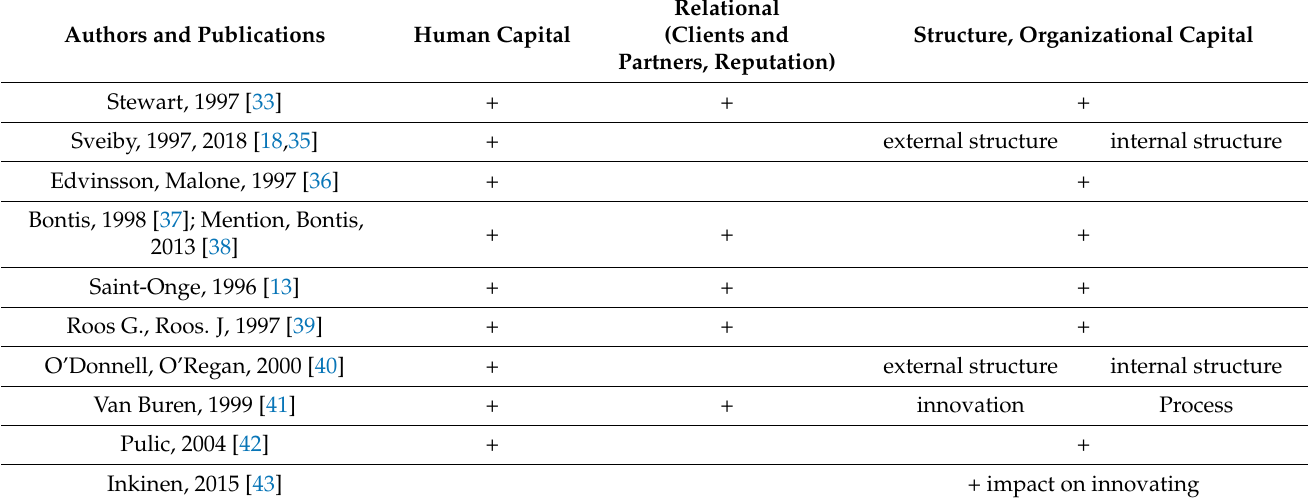
Table 1. Essential approaches to structure the intellectual capital of a